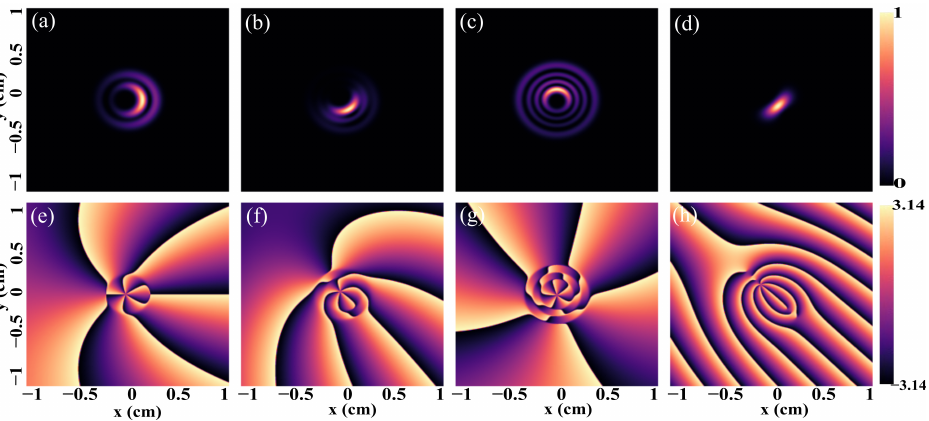
Figure 1. Simulated intensity (First row) and phase profile (second row) of asymmetric LG beams for different values of x 0 , y 0 , p , and l . ( a , e ) x 0 = 0, y 0 = 0.0002 i , p = 1 and l = 5 ( b , f ) x 0 = 0.0003 i , y 0 = 0.0002 i , p = 2 and l = 5 ( c , g ) x 0 = 0.0003 i , y 0 = 0, p = 3 and l = 5 ( d , h ) x 0 = 0.001 i , y 0 = 0.001 i , p = 3 and l = 5 for λ = 532 nm, w 0 = 1.2 mm and z = 0.